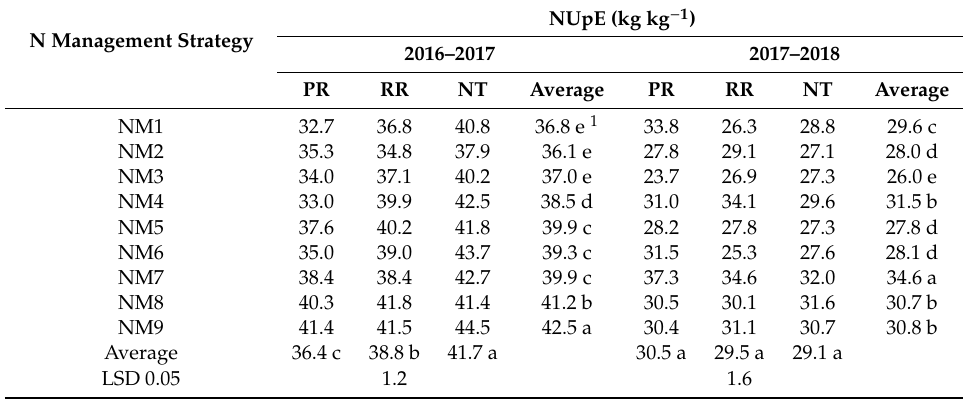
Table 6. NUpE of wheat under various tillage methods and N management